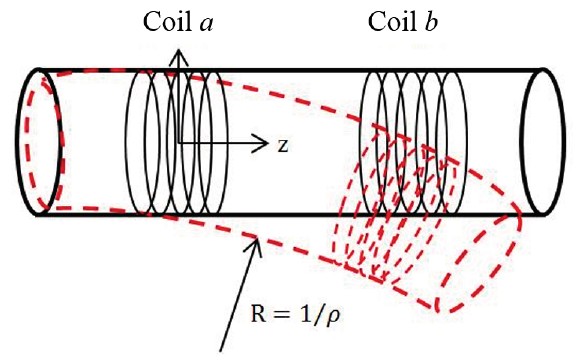
Figure 3. Bending of a flexible